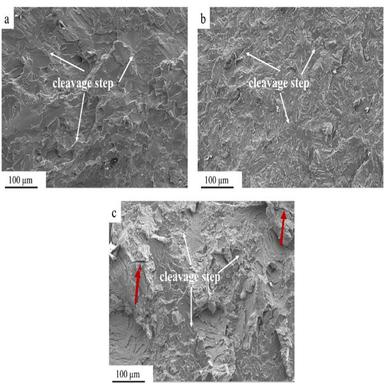
Fracture morphology of (aþb) titanium alloy side of the 0.5, 1, and 2 mm overlap specimens: (a) 0.5 mm, (b) 1.0 mm and (c) 2.0 mm.